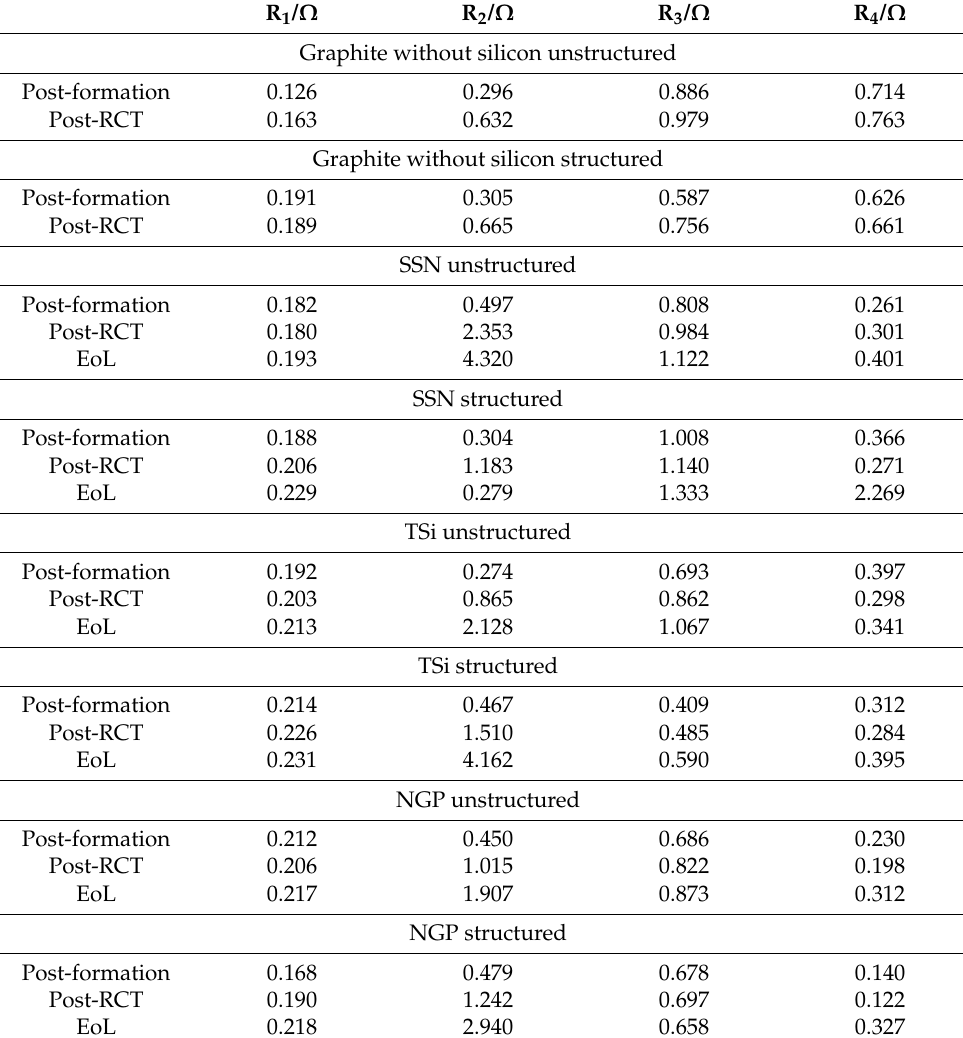
Table A3. Resistances of the pouch cells after formation and the rate capability test, and at